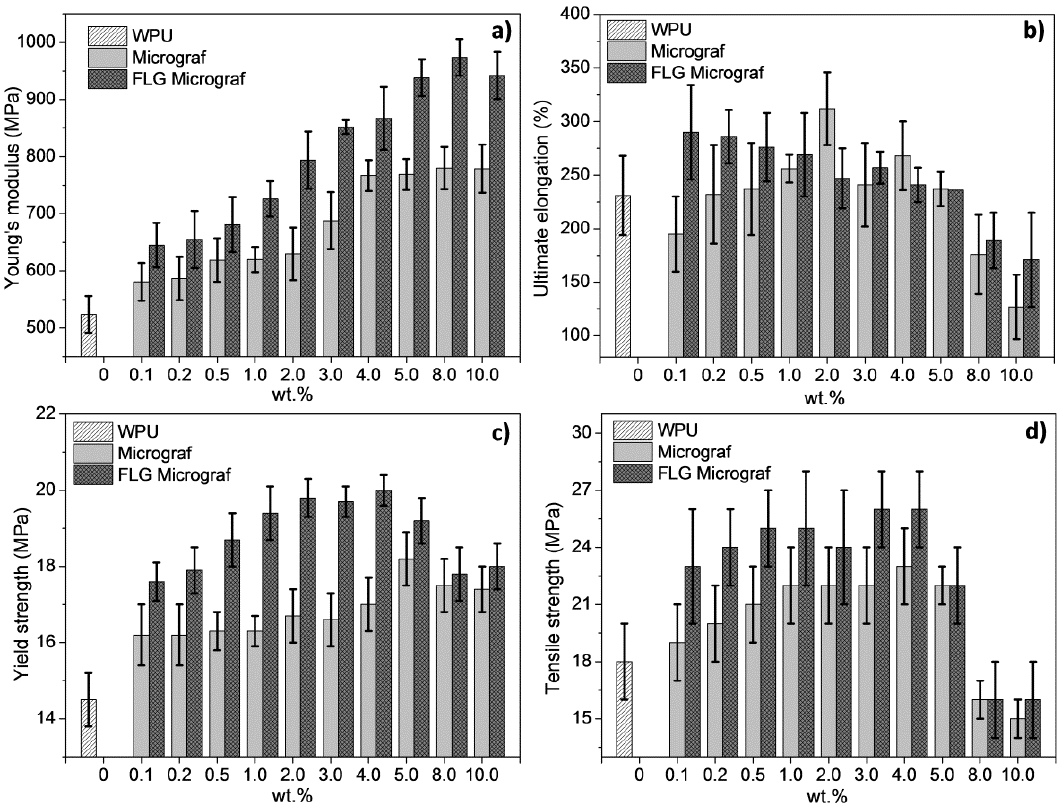
Figure 8. ( a ) Young’s modulus, ( b ) ultimate elongation, ( c ) yield strength, and ( d ) tensile strength of Figure 8. (a) Young’s modulus, (b) ultimate elongation, (c) yield strength, and (d) tensile strength of the Micrograf and FLG Micrograf WPU composite films at different the Micrograf and FLG Micrograf WPU composite films at different loadings.